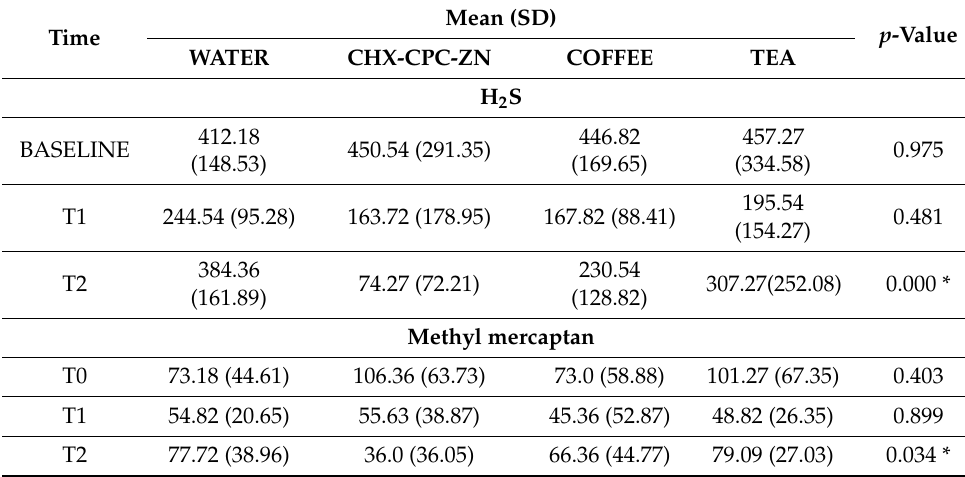
Table 3. Comparison of averages from four different interventions at given